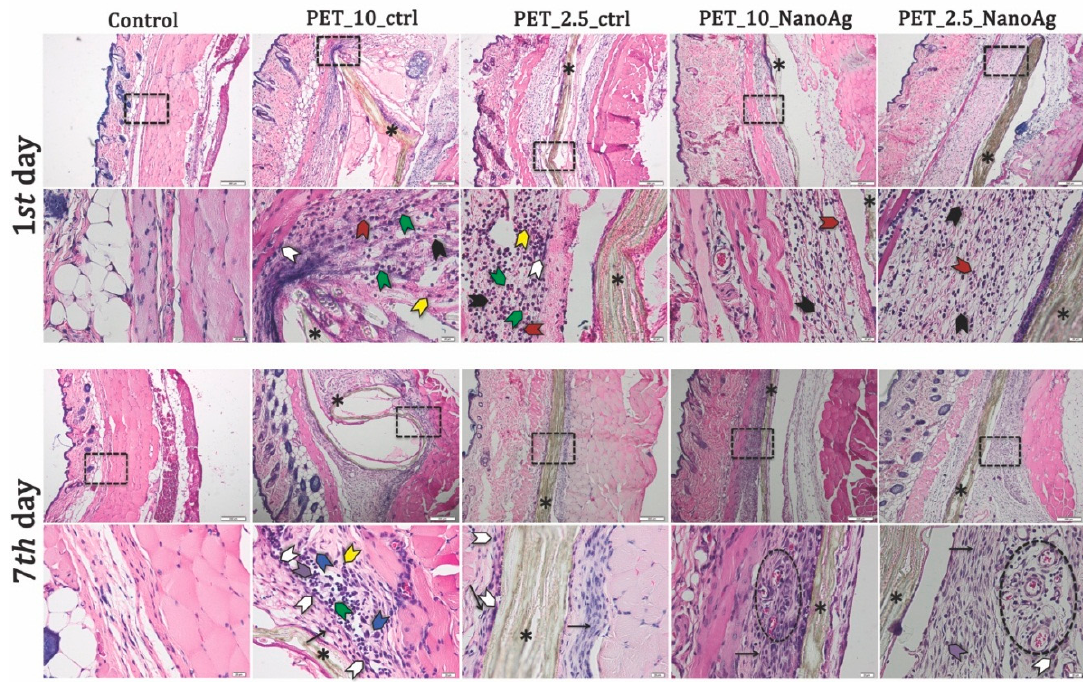
Figure 13. Representative histological images of PET_X_NanoAg mats-implanted sites in mice—days one and seven post-implantation. Neutrophils (black arrowhead); monocytes (green arrowhead); eosinophils (red arrowhead); macrophages (white arrowhead); plasma cells (purple arrowhead); giant cells (blue arrowhead); lymphocytes (yellow arrowhead); * implant (asterisk). Cells were stained with hematoxylin and eosin (H&E) stain. Scale bars = 200 and 20 µ m.